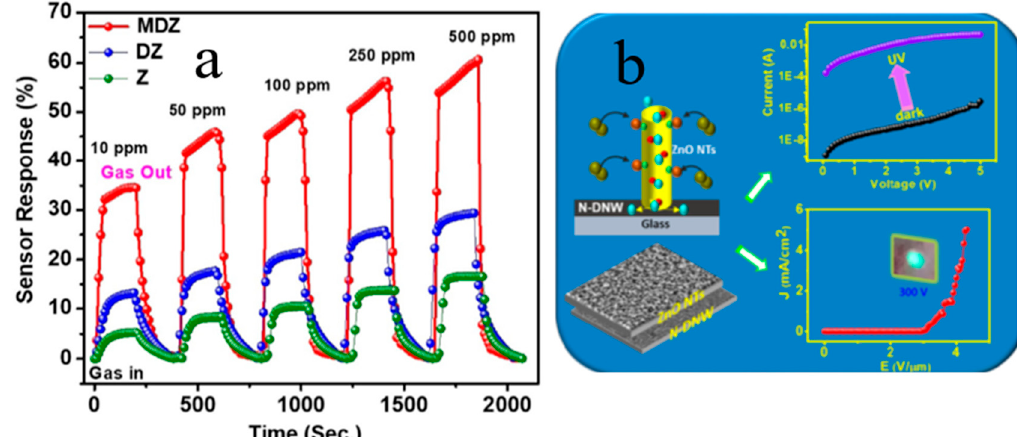
Figure 12. ( a ) Sensor response curve of pure ZnO NRs, ZnO NRs/ultra-nanocrystalline diamond, metallic glass/ultra- nanocrystalline diamond/ZnO NRs. ( b ) I-V characteristics and electron field emission properties of ZnO nanotubes incorporating diamond nanowires (NWs) in the dark and under UV illumination, respectively [85,86].